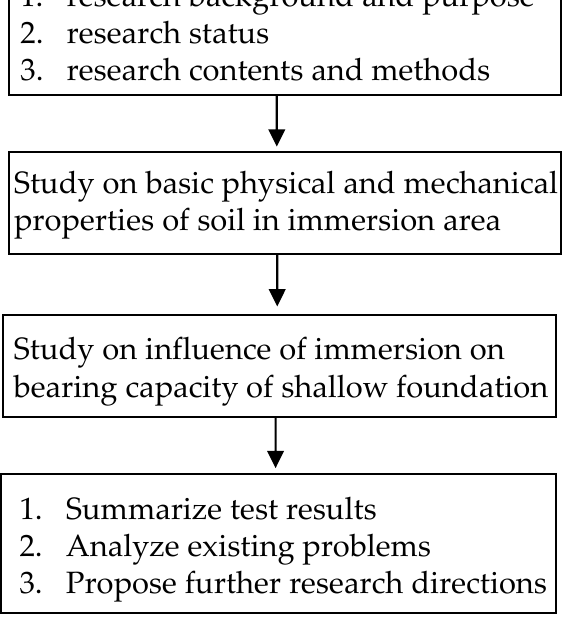
Figure 1. The Research Roadmap of this paper.